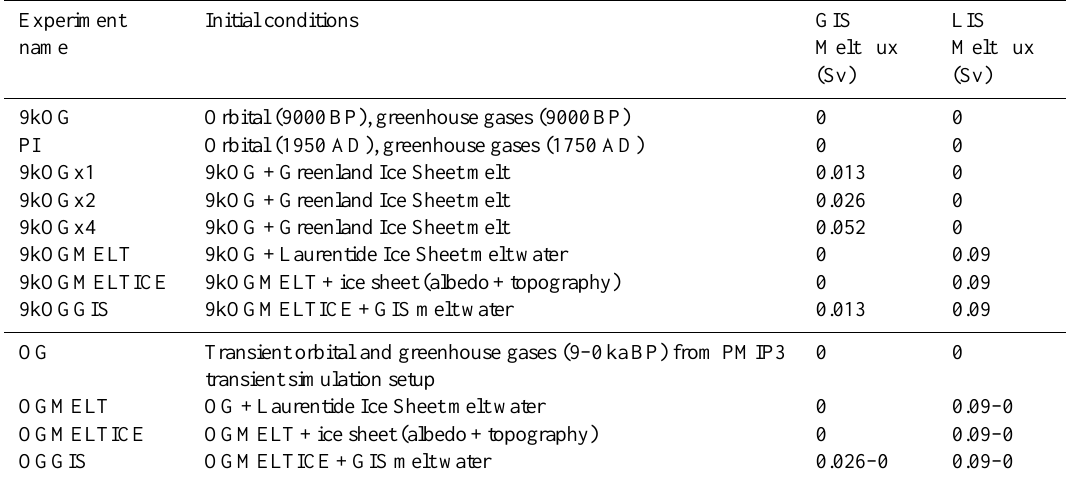
Table 1. Summary of the experimental design. Transient forcings are shown in Fig. 1. Orbital parameters and greenhouse gases are in line with the PMIP3 protocol (http://pmip3.lsce.ipsl.fr/) for transient simulations. Laurentide Ice Sheet melt water fluxes are from Licciardi et al.